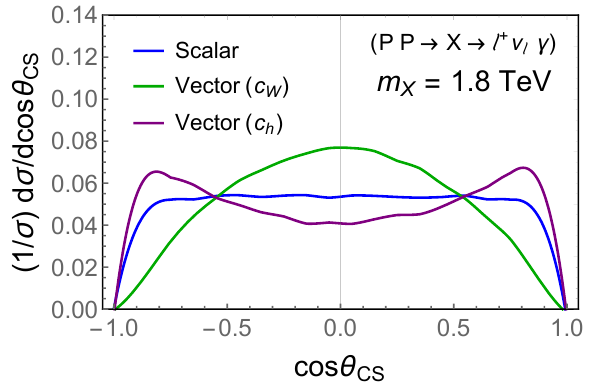
Figure 7 . Signal shape of the CS angle for W + ( ‘ + (cid:23) ) (cid:13) resonances. Heavy resonances show di(cid:11)erent shapes depending on the spin; scalar resonances decay isotropically whereas a spin one resonance creates di(cid:11)erent patterns depending on its couplings to gauge